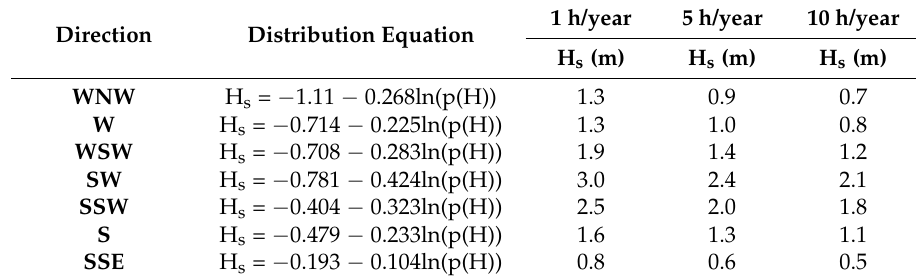
Table 1. Exceedance time interval and the probability distribution of significant wave heights (H s ) of ECMWF data for 2000–2016 [33].